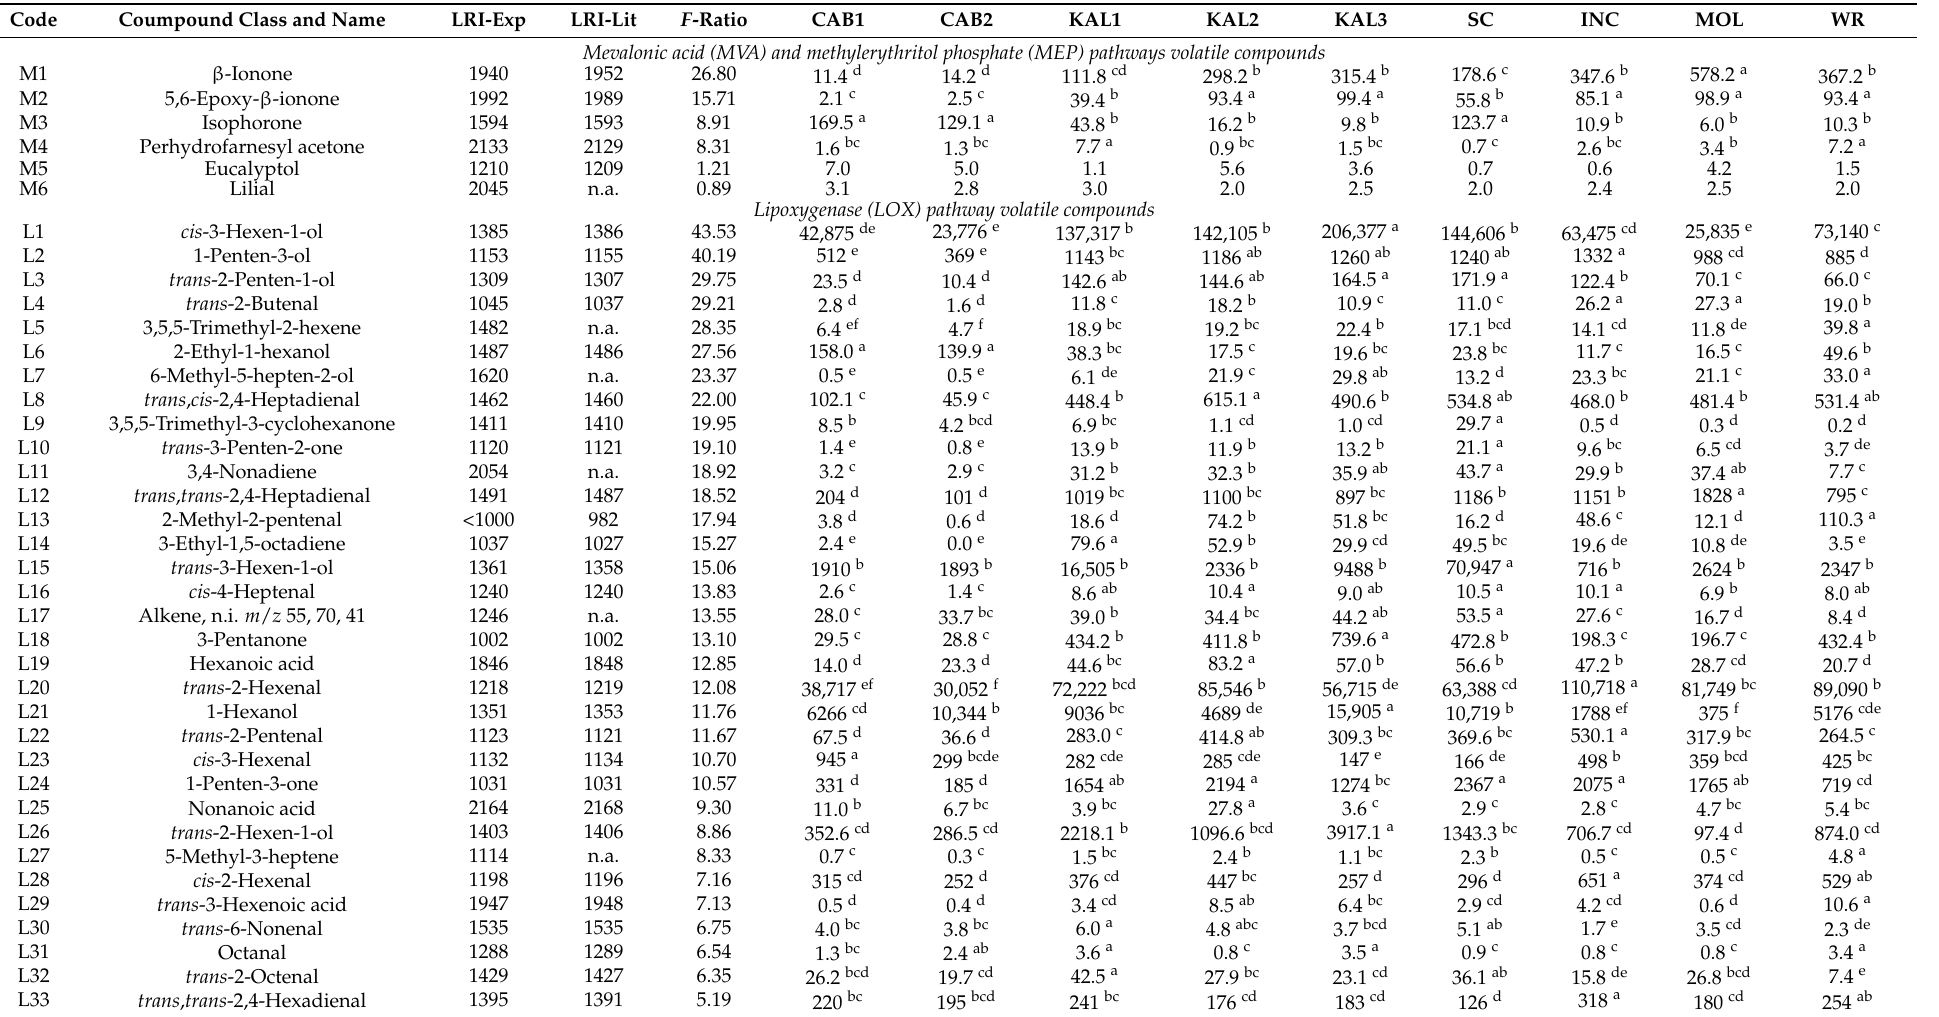
Table 1. Amounts of volatile compounds * found in various Brassicaceae species after headspace solid-phase microextraction followed by gas chromatography/mass spectrometry (HS-SPME-GC/MS) sorted by compound class and descending Fisher F